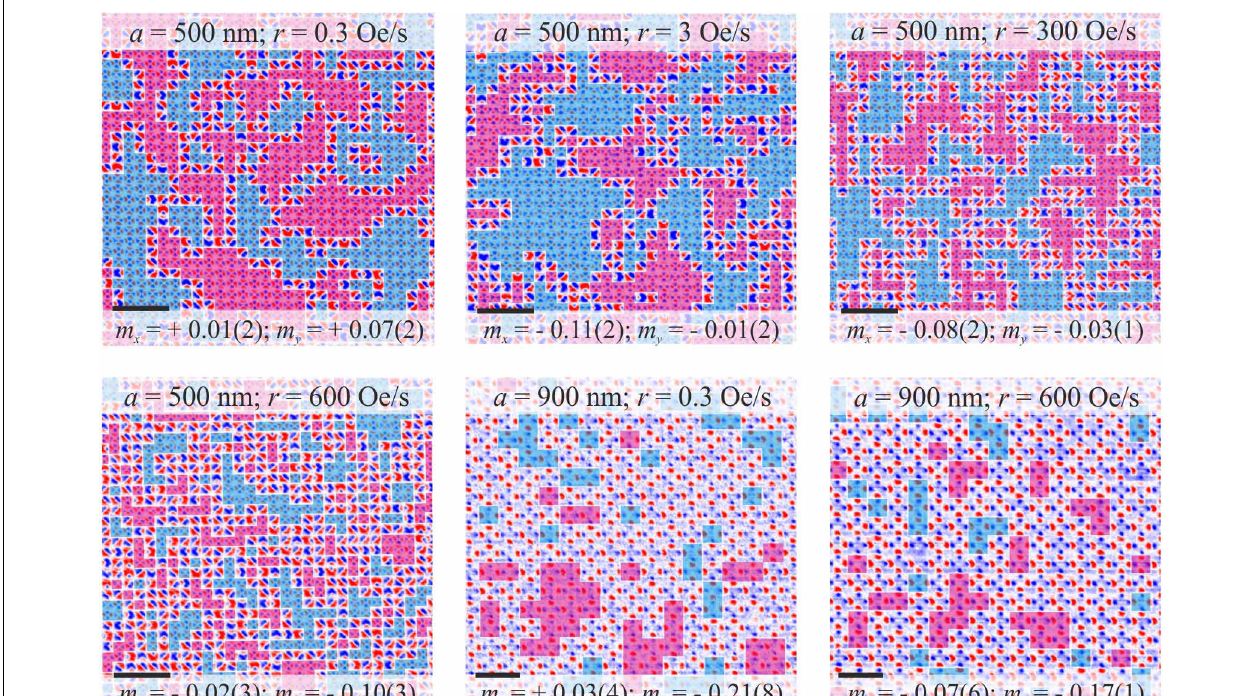
FIGURE 5 | MFM image series of square ice states for varying ramping rates r for the a = 500nm and a = 900nm samples of batch 1 (as quoted). Scale bars represent 2 µ m. The two GS phases are indicated by boxes tinted red or blue. For a = 500nm, decreasing